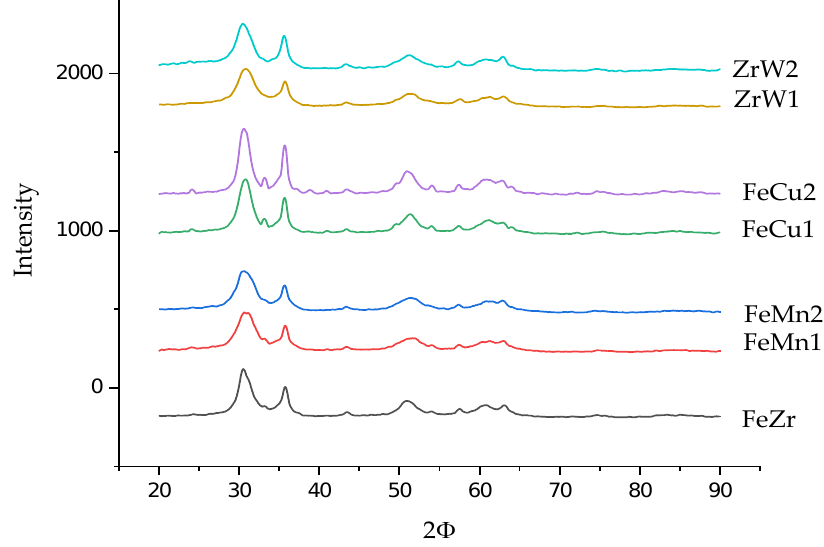
Figure 2. Powder x-ray pattern for the prepared doped systems.